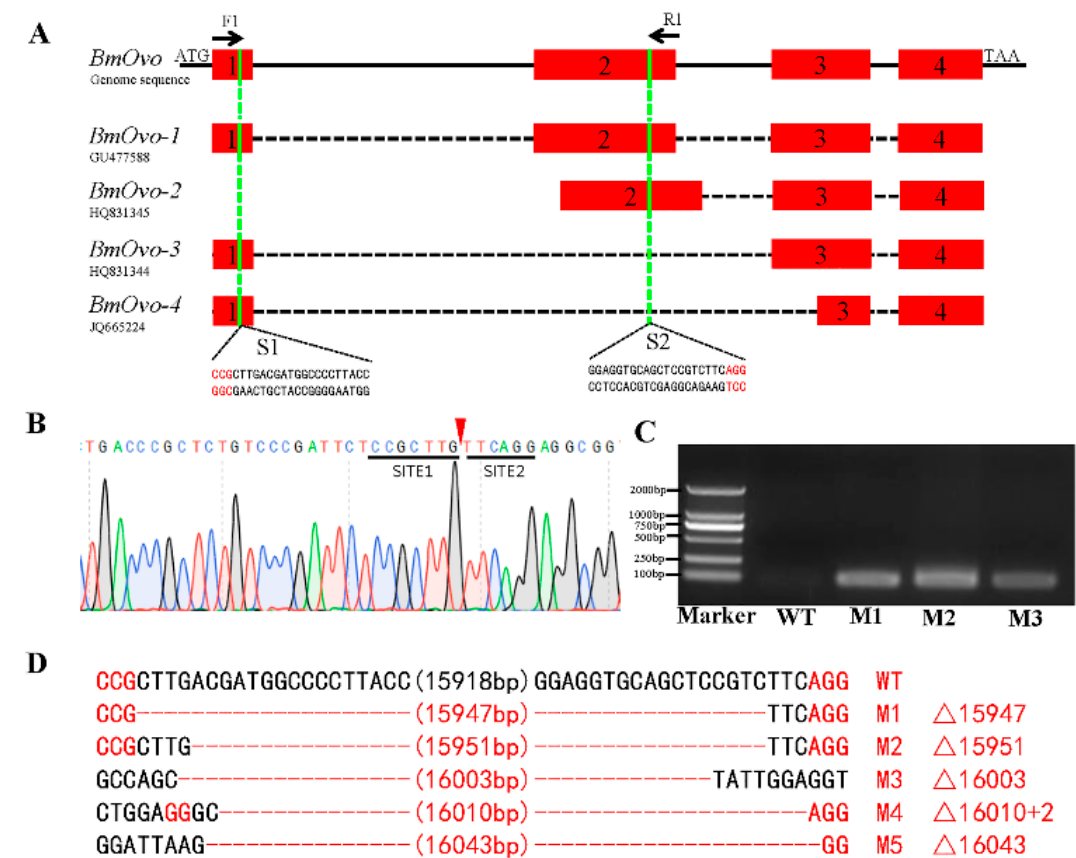
Figure 1. CRISPR / Cas9-induced mutagenesis results in knockout of BmOvo . ( A ) Schematic of the targeted region of BmOvo . The boxes indicate exons, and the black lines represent introns. The proto spacer adjacent motif (PAM) sequence is shown in red. The sgRNA target sites, S1 and S2, are located on the sense strand within exon 1 and exon 3, respectively. Binding sites for primers F1 and R1 are indicated. The sgRNA target sequence is shown. ( B ) Representative sequencing chromatogram of PCR products from the genome sequencing of BmOvo mutants. SITE1 and SITE2 indicate sequences of a portion of each target site sequence. In wild-type insects, the two target sites are separated by about 16 kb, but the target sites are adjacent in mutants where BmOvo has been knocked out. ( C ) Genomic PCR detected BmOvo deletion mutants. WT, wild type. M1, M2, and M3 are the mutants. ( D ) Sequences of BmOvo deletion mutants. The numbers in parentheses indicate the number of base pairs deleted between the two targeted regions relative to the wild-type sequence. The sequence in red indicates the PAM sequence.